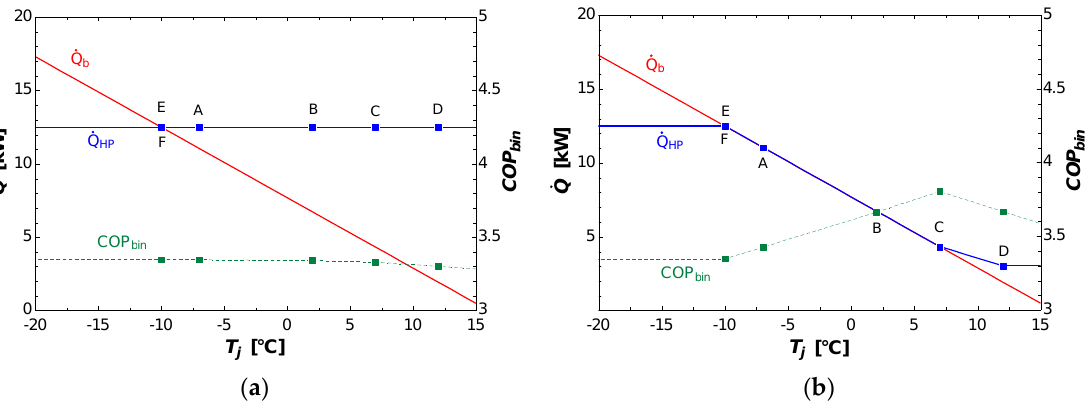
Figure 4. Heating load curve, heat capacity curve, and COP bin of the heat pump as a function of the outdoor temperature for a heat pump with fixed outlet temperature and ( a ) a fixed speed compressor, ( b ) a variable speed compressor.